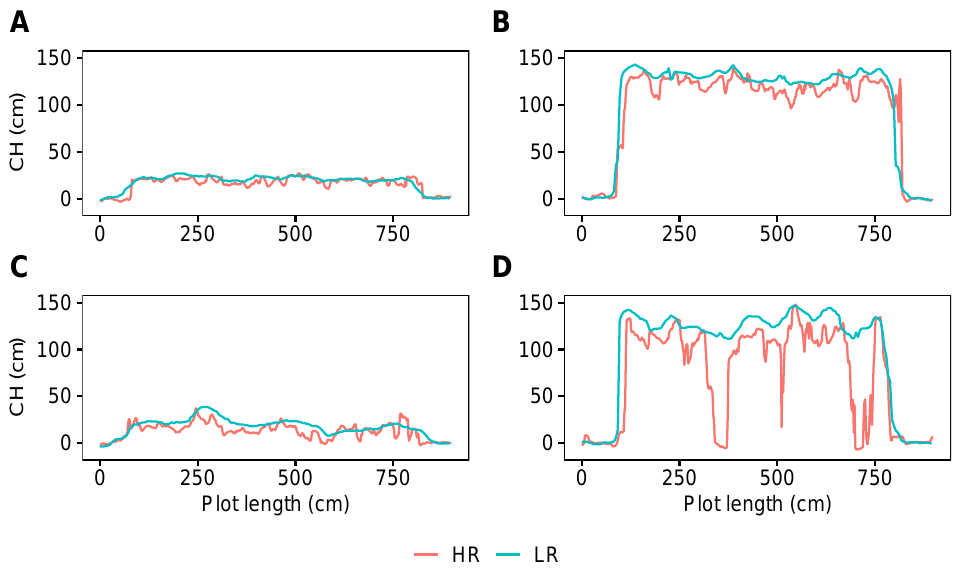
Figure 6. Canopy height (CH) profile from transects of a low-resolution UAV mission (LR) and high-resolution UAV mission (HR) of ( A ) low-rise and smooth, ( B ) high-rise and smooth, ( C ) low-rise and rough, and ( D ) high-rise and rough canopy of cover crops